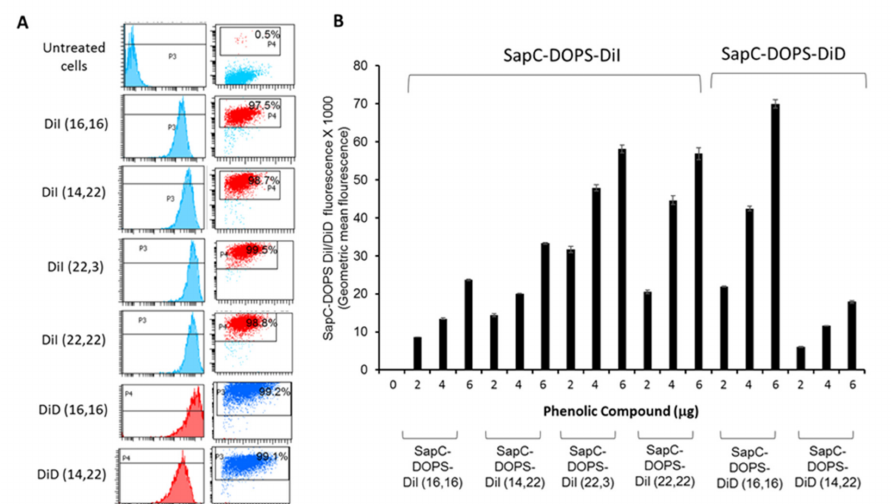
Figure 3. Saposin C-dioleoylphosphatidylserine (SapC-DOPS) nanovesicles assembled with the iodinated phenolic DiI / DiD compounds robustly target U87 ∆ epidermal growth factor receptor (EGFR) GBM cells. ( A ) The left row of panels shows the histograms and the right row of panels shows dot plots with the compounds internalized by the cells. U87 ∆ EGFR cells treated with 6 µ g of the indicated SapC-DOPS DiI / DiD compounds for 3 h exhibit robust fluorescence as evident by flow cytometry. Untreated cells were used as controls. ( B ) Graphical representation of flow cytometry data indicating the fluorescence of the cells loaded with 2, 4 or 6 µ g of the dyes.